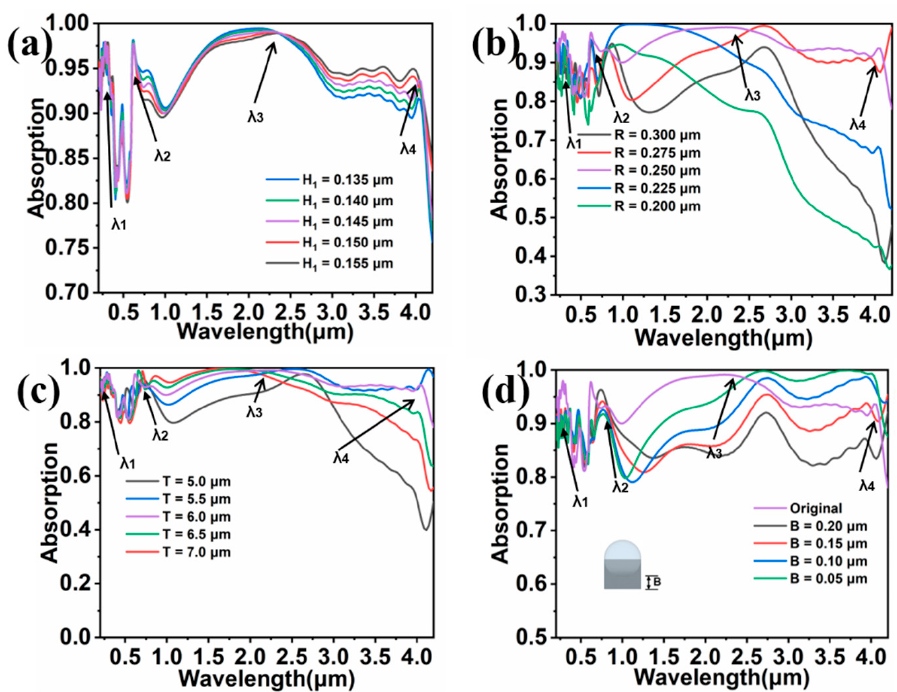
Figure 7. Evolution of absorption spectrum with structural parameter of ( a ) H 1 , ( b ) R, ( c ) T, and ( d ) B.